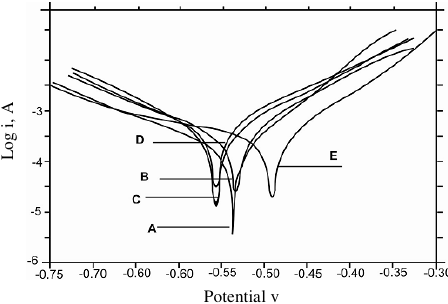
Figure 4 . Polarization curves for mild steel corrosion in phosphoric acid with AV (A-blank, Table 2. Potentiostatic polarization studies for mild steel corrosion in hydrochloric acid with AV o . N S .